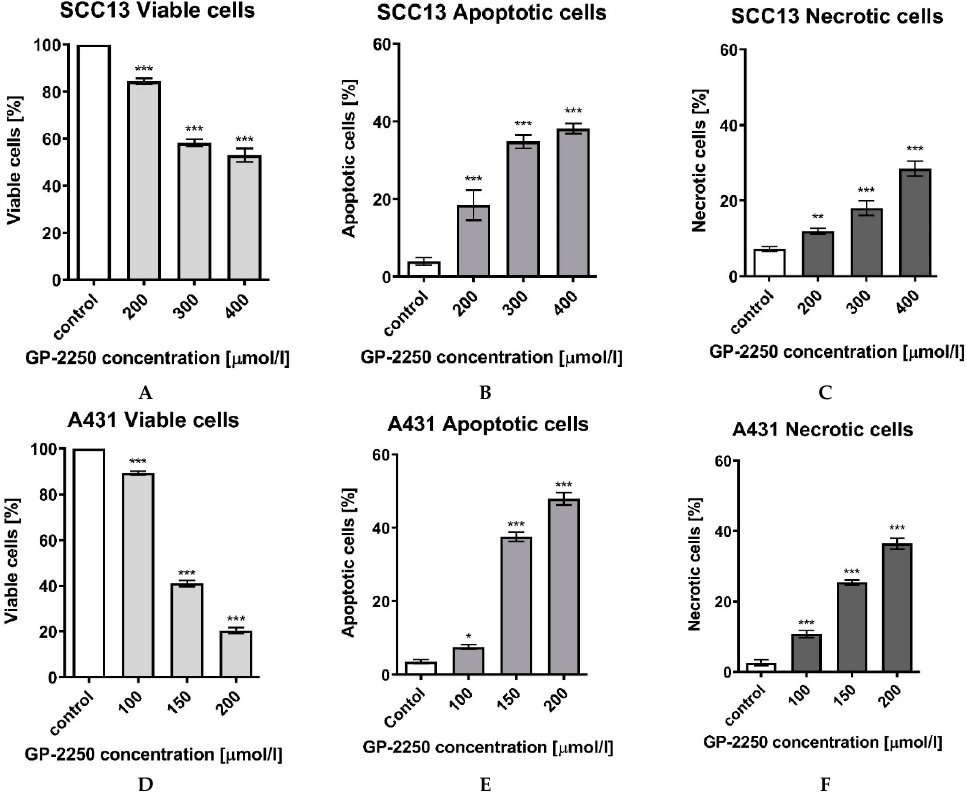
Figure 4. Effects of Substance GP-2250 in different cSCC cell lines, measured by FCM-analysis. SCC13 cells were incubated with GP-2250 (200, 300 and 400 μ mol/L) and A431 cells were incubated with GP-2250 (100, 150 and 200 μ mol/L), both for 24h. The percentages of viable ( A ), apoptotic ( B ) and necrotic SCC13 cells ( C ) as well as viable ( D ), apoptotic ( E ) and necrotic A431 cells ( F ) were determined by FCM-analysis with Annexin V-FITC and Propidium iodide. Values are expressed as mean value ± SD of 6 independent experiments. The asterisk symbols indicate significant differences between controls.